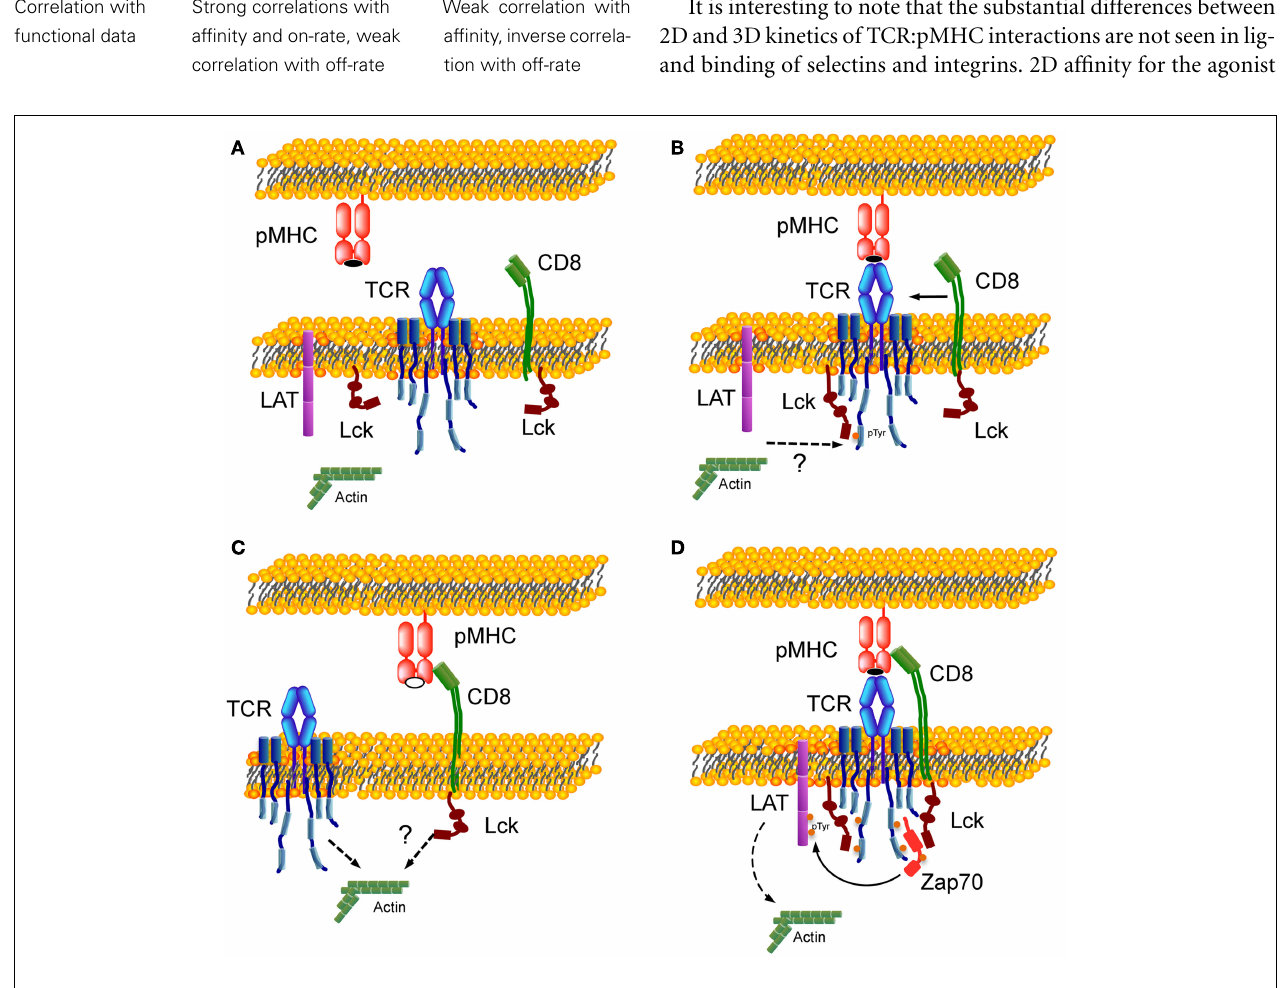
symbol). (D) Assembly ofTCR:pMHC:CD8 trimolecular functional complex. Lck molecules are shown in two states – free-state and bound to CD8 – and in two conformations. Dotted arrows indicate an involvement of actin cytoskeleton duringT cells activation (Burkhardt et al.,